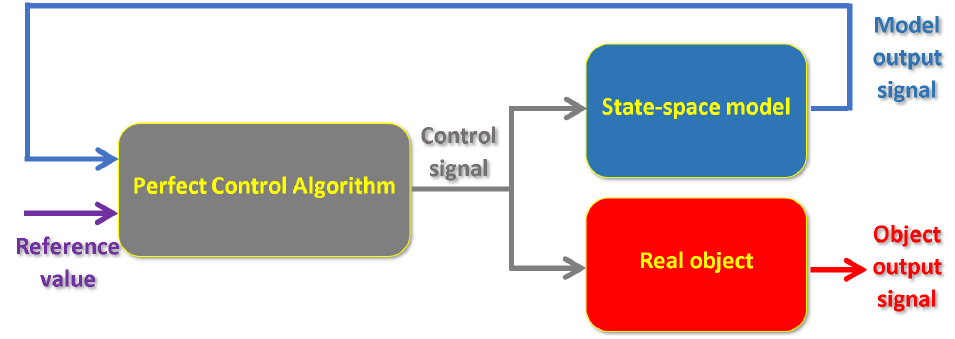
Figure 9. Diagram of control system (source: